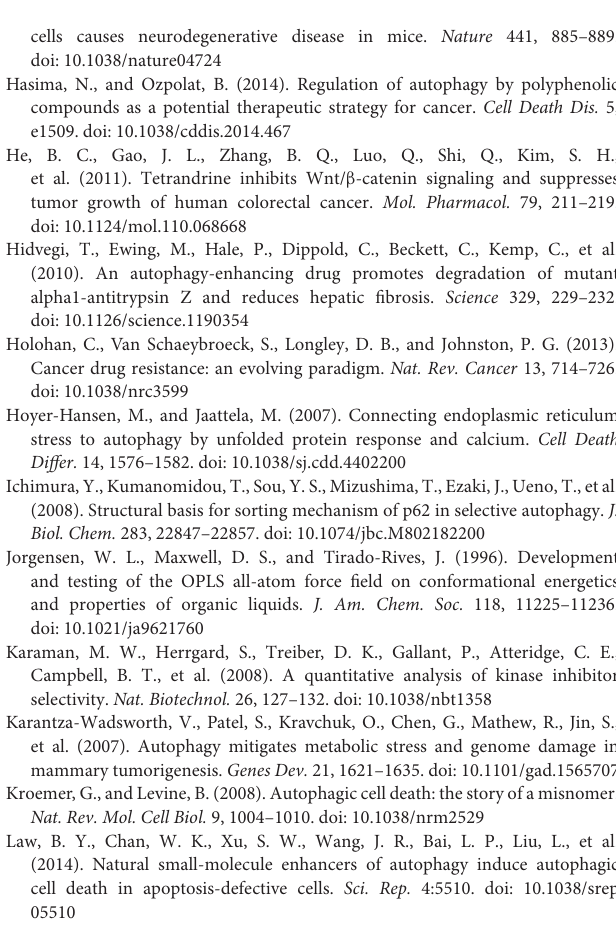
Figure S1 | Bioactivity guided purification of Stephaniae tetrandrae crude extract. (A) MCF-7 cells expressing GFP-LC3 were treated with the ethanol-extracted